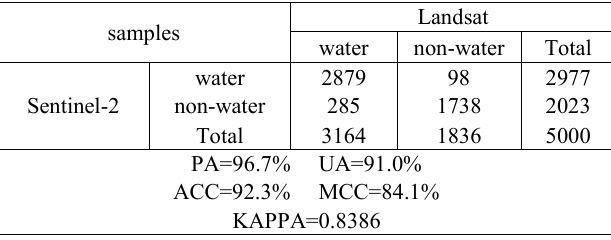
Table 1. Confusion matrix for the accuracy assessment of surface water extraction results based on random sampling points.